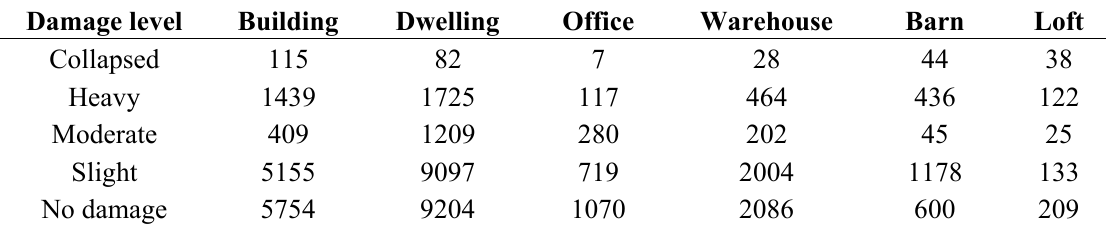
Table 2. Damage distributions reported by Governorship of Kütahya